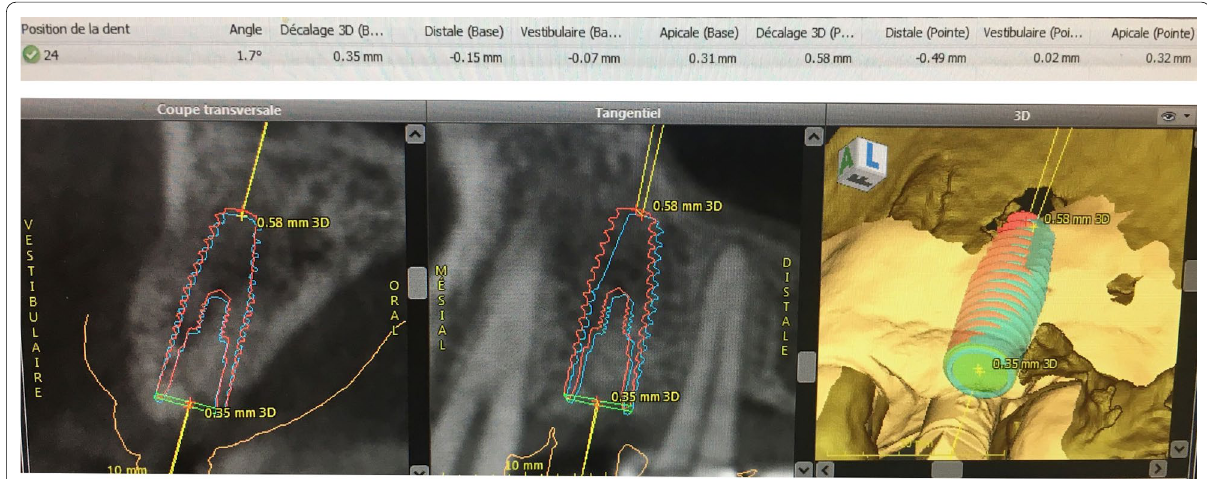
Fig. 3 Deviation measurement from treatment evaluation mode in coDiagnostiX ® software version 9.7 (Dental wings Inc.). Implant illustrate (red line): final implant position, (blue line): planned implant position, Angle (°): angle deviation in degrees, Base (mm): deviation at implant shoulder in mm, Tip (mm): deviation at implant apex in mm, 3D offset: deviation in three ‐ dimensional directions, Distal: deviation to mesiodistal direction, : deviated to distal direction, : deviated to mesial direction, Vestibular: deviation at buccolingual direction, : deviated to lingual direction, : + − + − deviated to buccal direction, Apical: deviation at apicocoronal direction. : deviated to apical direction. : deviated to coronal + −